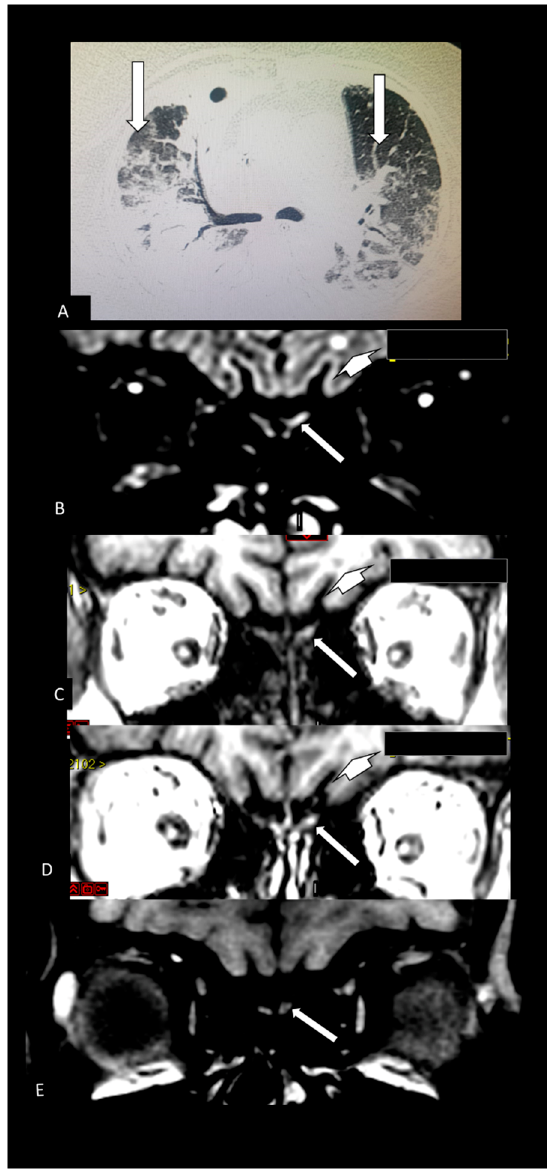
Figure 10. Case 27—The Chest CT shows more than 50% of typical lung opacity of COVID 19 pulmonary injury, bilaterally ( A , arrows). The MRI shows hyperintense lesion on 3D FLAIR ( B , arrow) [16] and also on pre ( C , arrow) [16] and post contrast SPGR T1 WI ( D , arrow) [16]. This is suggestive of component of probably methemoglobin in this left olfactory bulb lesion which seems be little bigger and asymmetric compared with the apparently normal right olfactory bulb. This asymmetry in size is better seen on FLAIR ( B ) [16]. There is also a small round hyperintense lesion in the subcortical white matter in the left frontal lobe on FLAIR ( B , short arrow) which is hypointense on T1WI ( C , short arrow) and does not enhance on post-contrast T1WI ( D , short arrow) being nonspecific [16]. The MRI performed 3 months later shows on pre contrast fat suppression T1 WI ( E ) that there is reduction on hyperintensity of the left olfactory bulb